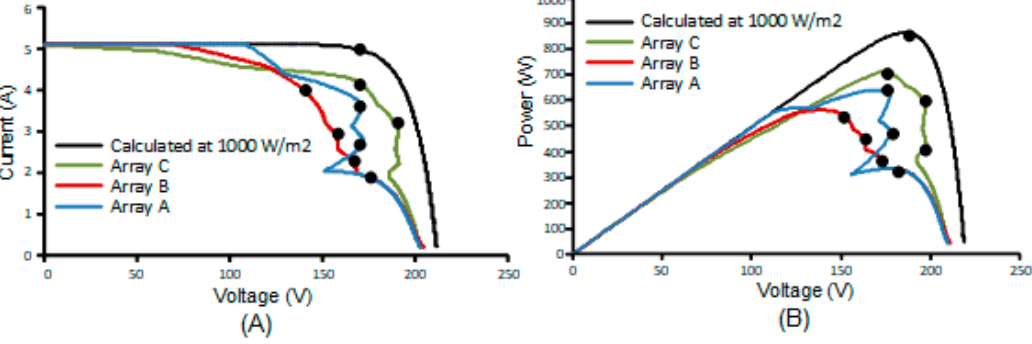
Figure 4. ( A ) PV system current voltage and ( B ) power voltage characteristic curves with uniform and Figure 4. (A) PV system current voltage and (B) power voltage characteristic curves with uniform and Figure 4. (A) PV system current voltage and (B) power voltage characteristic curves with uniform and non-uniform irradiance conditions. non-uniform irradiance conditions. non-uniform irradiance conditions. Figure 4. (A) PV system current voltage and (B) power voltage characteristic curves with uniform and non-uniform irradiance conditions.